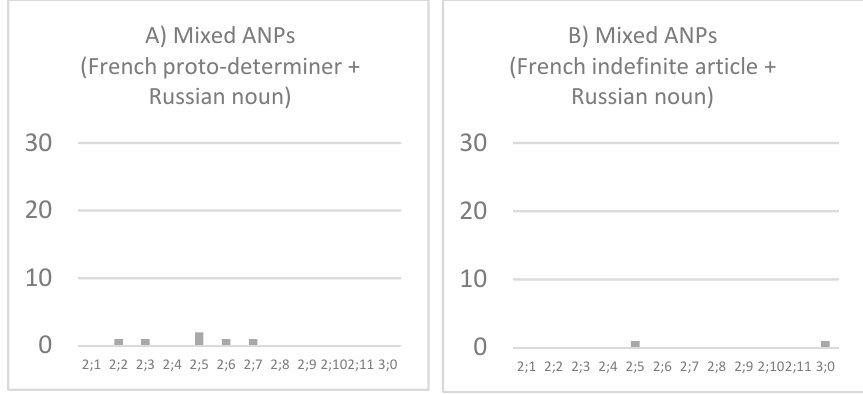
Figure 3. Frequency of use of mixed ANPs in French-Russian, according to age.